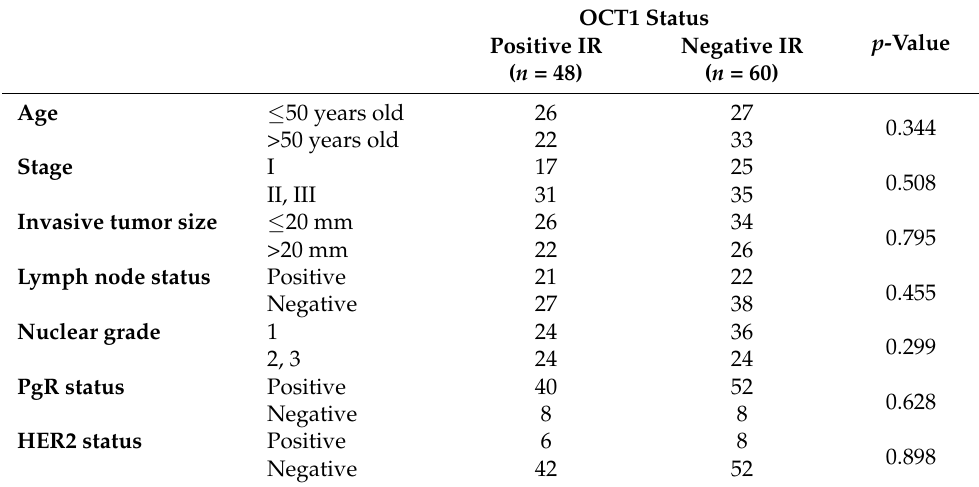
Table 1. Relationship between OCT1 immunoreactivity and clinicopathological parameters in ER- positive breast cancer patients.